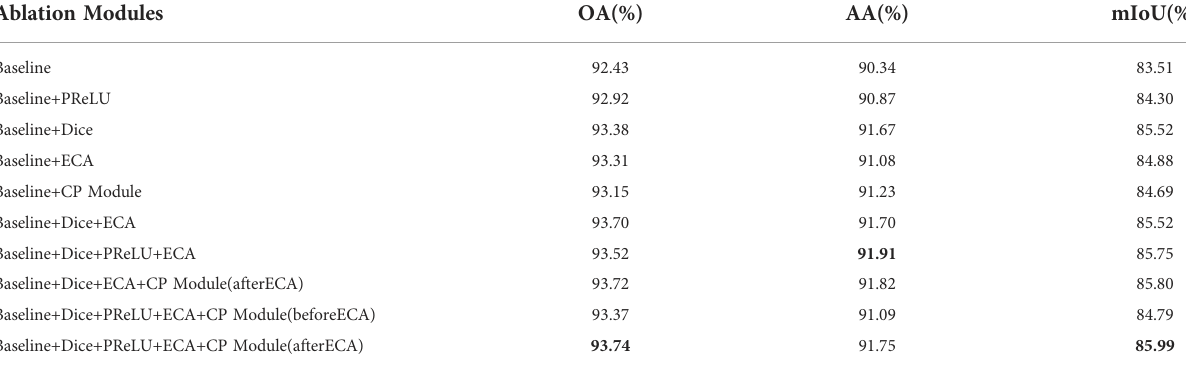
TABLE 4 Ablation experiments.